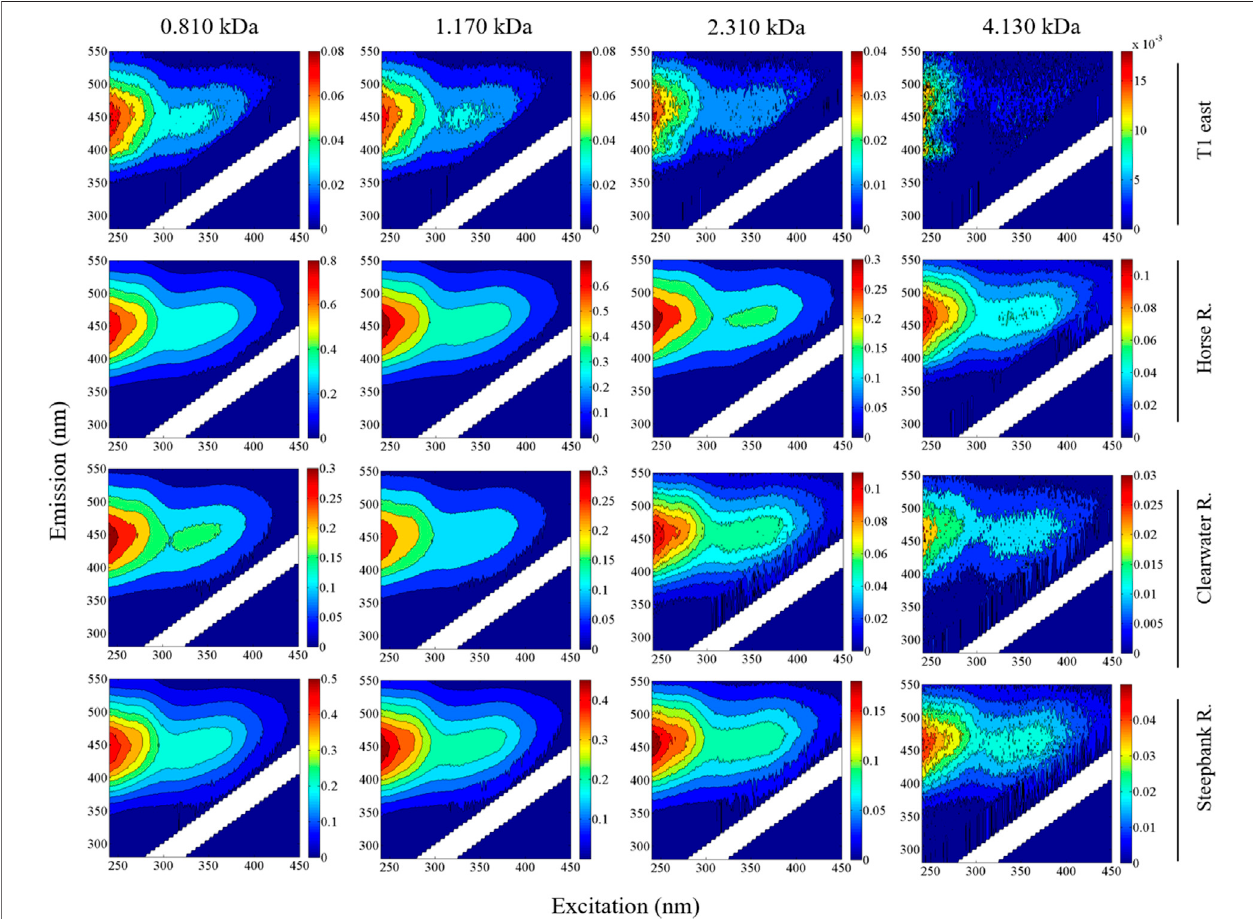
FIGURE5| Size-resolvedEEMsforamainstemsite(T1east)freeoftributaryinputandmajortributaries(i.e.,HorseRiver,ClearwaterRiver,andSteepbankRiver)in the LAR. Fluorescence intensities are normalized to Raman units (r.u.).